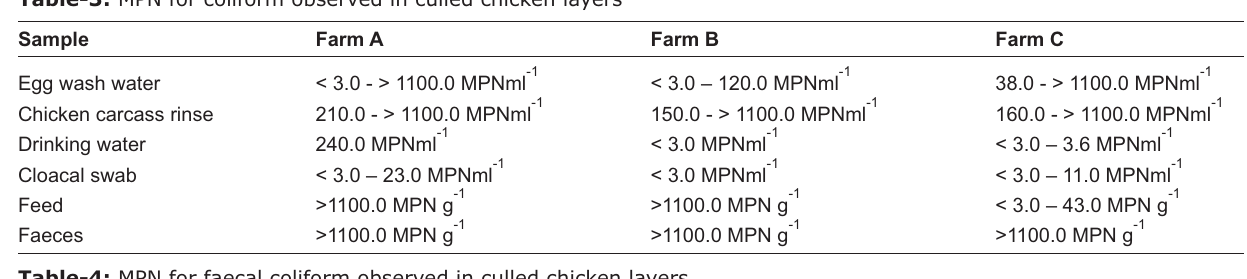
Table-4: MPN for faecal coliform observed in culled chicken layers Sample